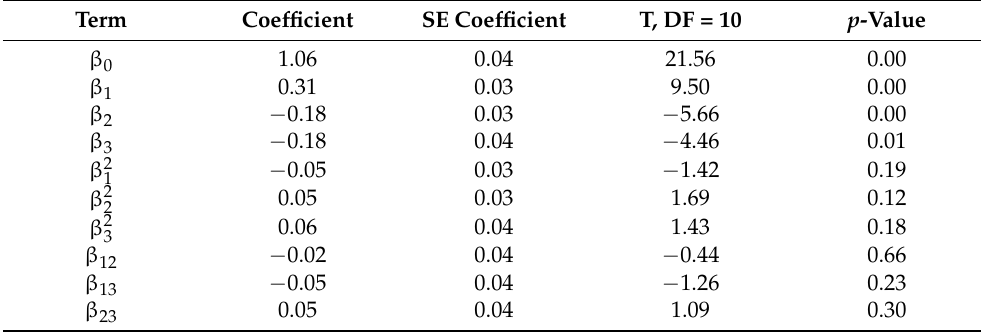
Table 1. ANOVA for the second order response surface